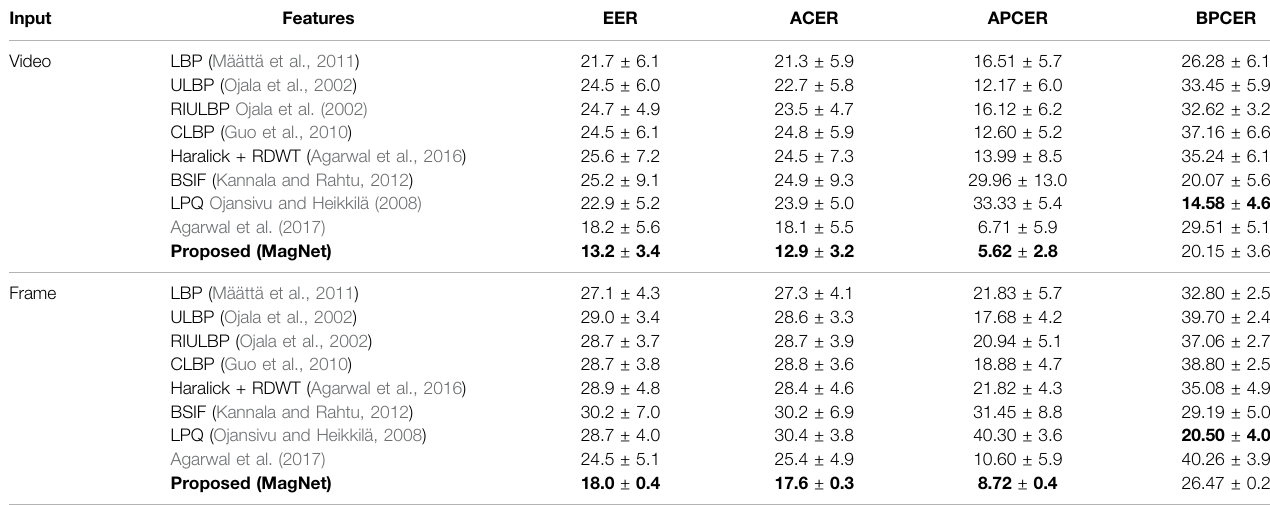
TABLE 3 | Performance (%) of the proposed and existing algorithm for video and frame based presentation attack detection on the proposed SnapChat database. The results are reported in terms of the average equal error rate and classi fi cation error rates along with standard deviation ( ± ).